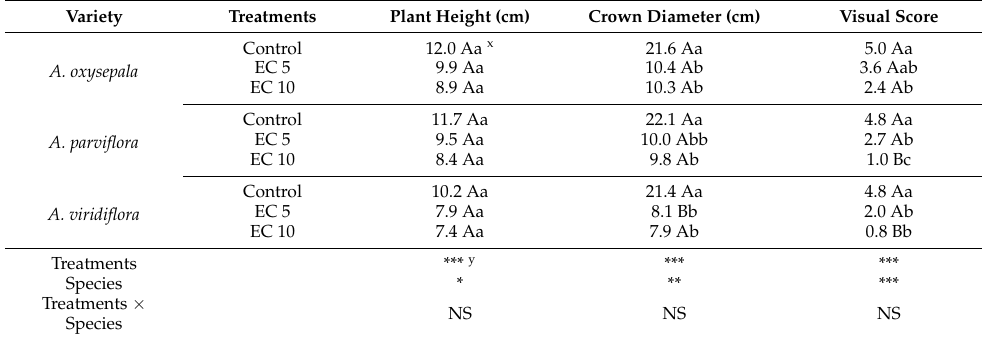
Table 6. Plant height, crown diameter, and visual score of A. oxysepala , A. parviflora , and A. viridiflora irrigated with tap water (control) or salt solution at an electrical conductivity (EC) of 5 dS · m − 1 (EC 5) and 10 dS · m − 1 (EC